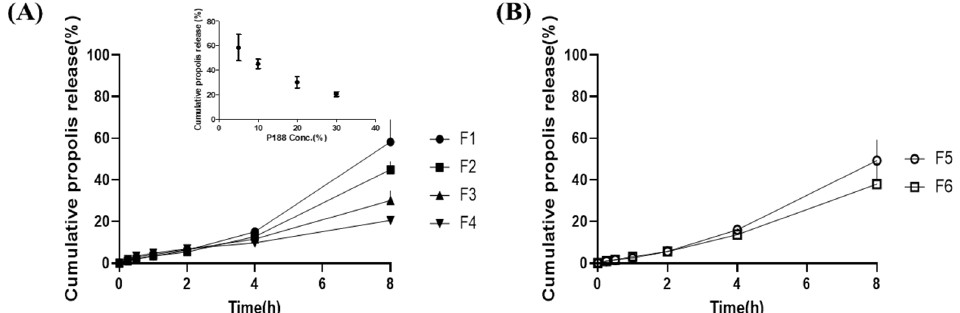
Figure 2. Release profiles of propolis-loaded ( A ) poloxamer 188 and ( B ) poloxamer 407 formulations. Data are expressed as mean ± S.D. ( n = 3). ( A ) Insert: a graph plotted between the P188 concentration of F1, F2, F3, and F4 and their cumulative release % at 8 h.